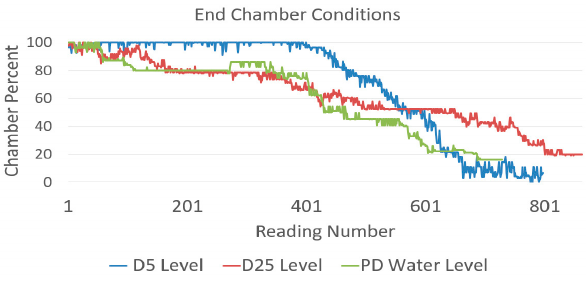
Figure 17. Fall in observed chamber percentage during end chamber conditions.